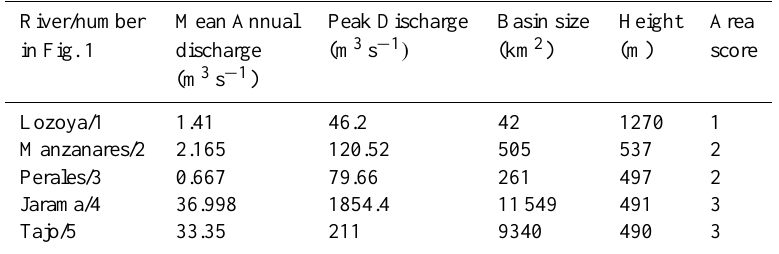
Table 1. Mean annual discharge and peak discharge of river sections in the Tagus basin, showing the range of area used to calculate the quantitative indices. The locations of the gauging stations are shown in Fig. 1.